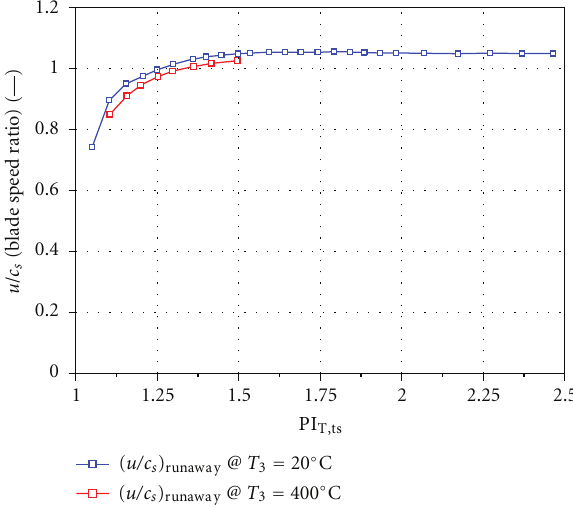
Figure 14: Test setup for unsteady turbine performance measure- ment.